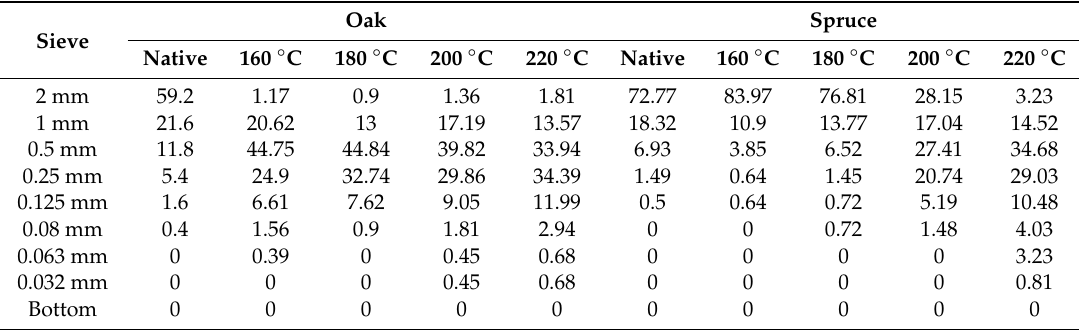
Table 1. Percentage of particles on individual mesh sieves in the case of both oak wood and spruce wood with feed rate v f = 6 m · min − 1 .